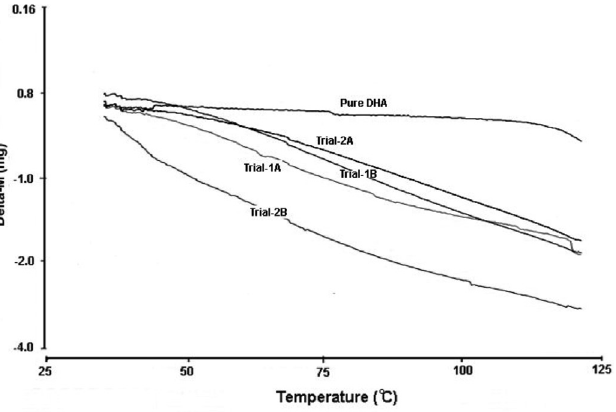
FIGURE 5 - TGA comparison of pure DHA and DHA granules.